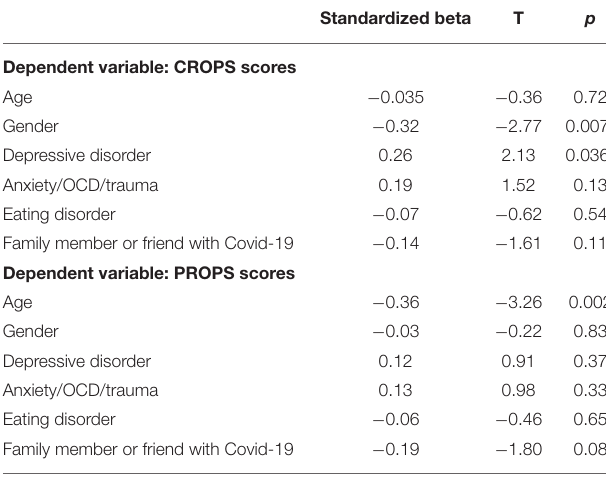
TABLE 3 | Regression for CROPS and PROPS scores, predictors: age and gender, type of diagnosis as dummy variable: depressive